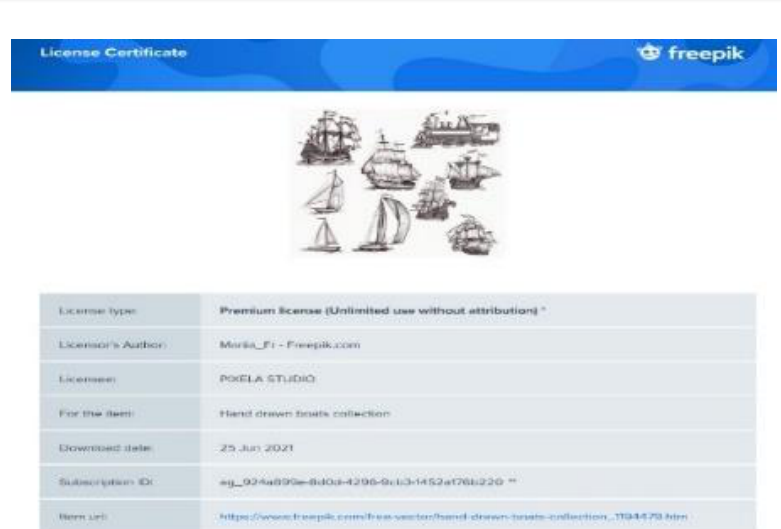
Figure 2. Illustration design display